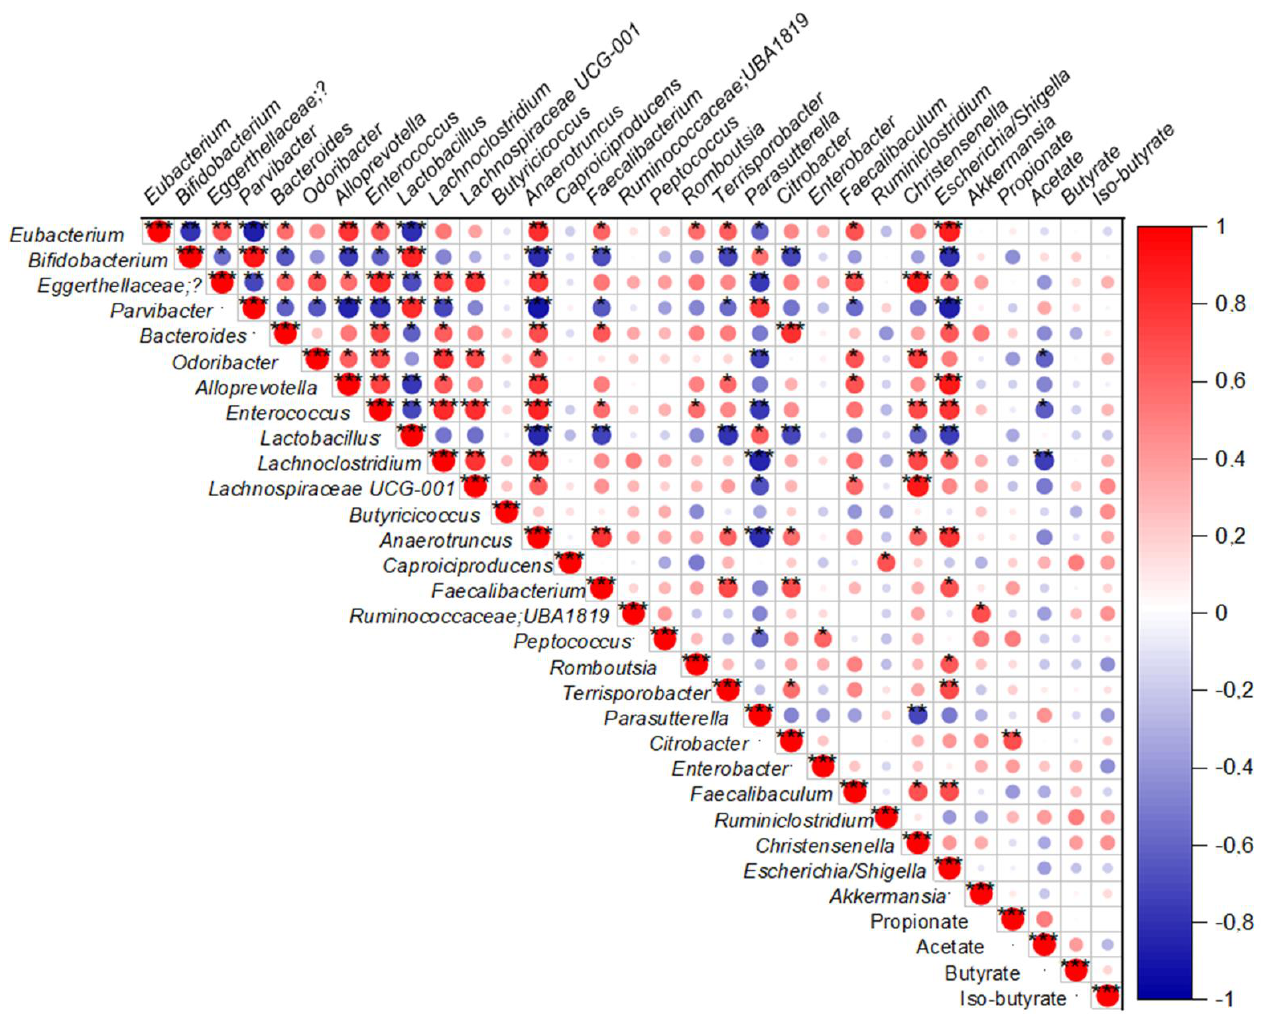
Figure 6. Spearman correlation analysis of fecal SCFAs and selected fecal genus from all mice. Dots in red mean positive correlation, whereas dots in blue mean negative correlation. * p < 0.05, ** p < 0.01, *** p < 0.001.